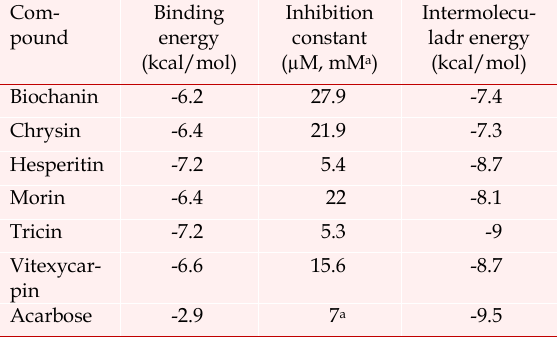
Docking parameters of the selected flavonoids